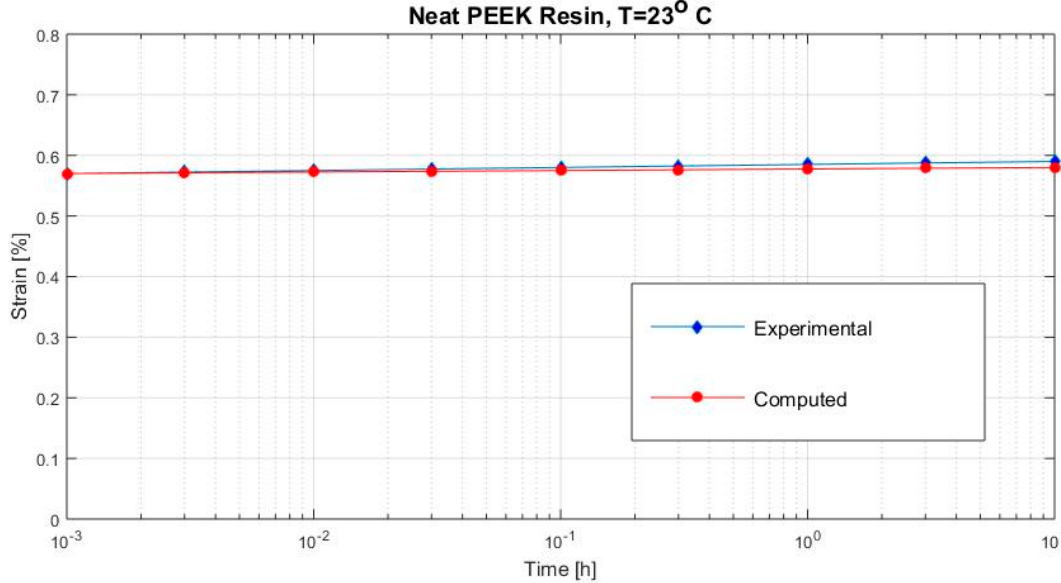
Figure 2. Creep strain (neat polyether-ether-ketone (PEEK) resin subjected to σ 22 = 26 MPa at 23 ◦ C).